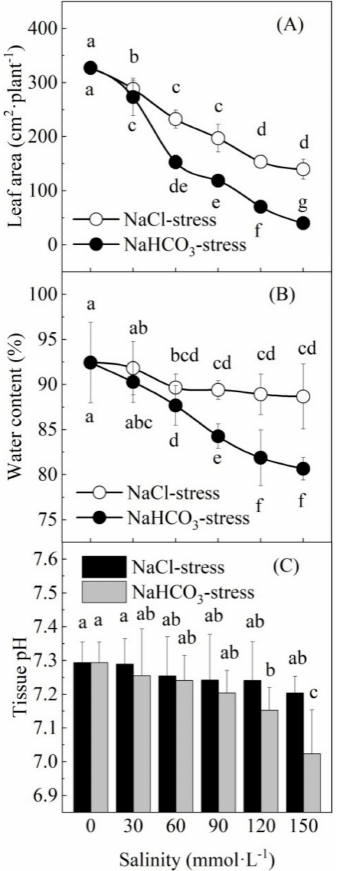
Figure 2. E ff ects of NaCl and NaHCO 3 stresses on leaf area ( A ), plant water content ( B ), fresh leaves tissue pH ( C ) of common bean ( Phaseolus vulgaris ) seedlings. Common beans were treated with NaCl (30–150 mmol · L − 1 , pH 6.65–6.86) and NaHCO 3 (30–150 mmol · L − 1 , pH 8.17–8.27) stresses. Data points and bars represent the mean ± SD of three replicates. Values followed by di ff erent letters in the same subgraph are significantly di ff erent at the 5% level among the various concentration treatments of neutral salt conditions or alkaline salt conditions, according to Duncan’s new multiple range